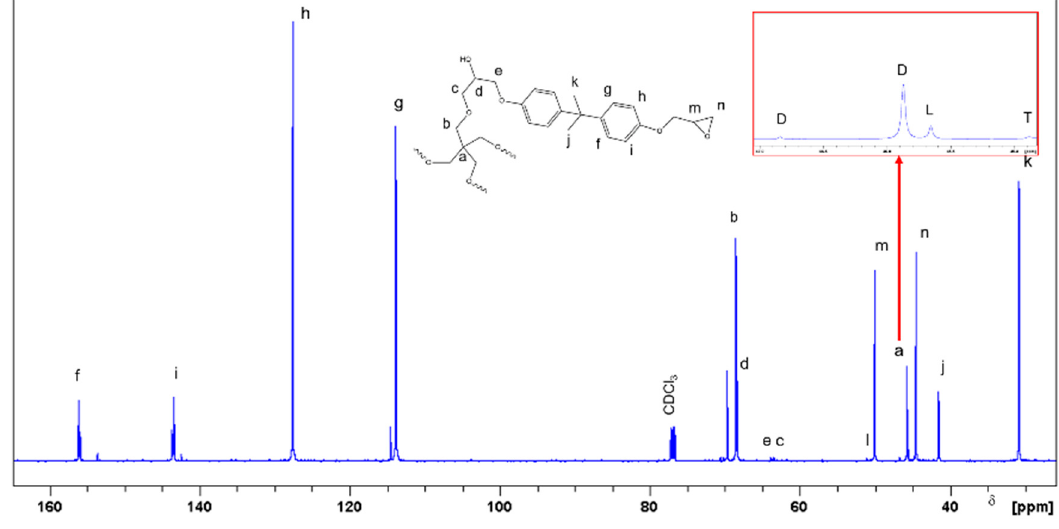
Figure 4. 13 C NMR spectrum of HBE resin.